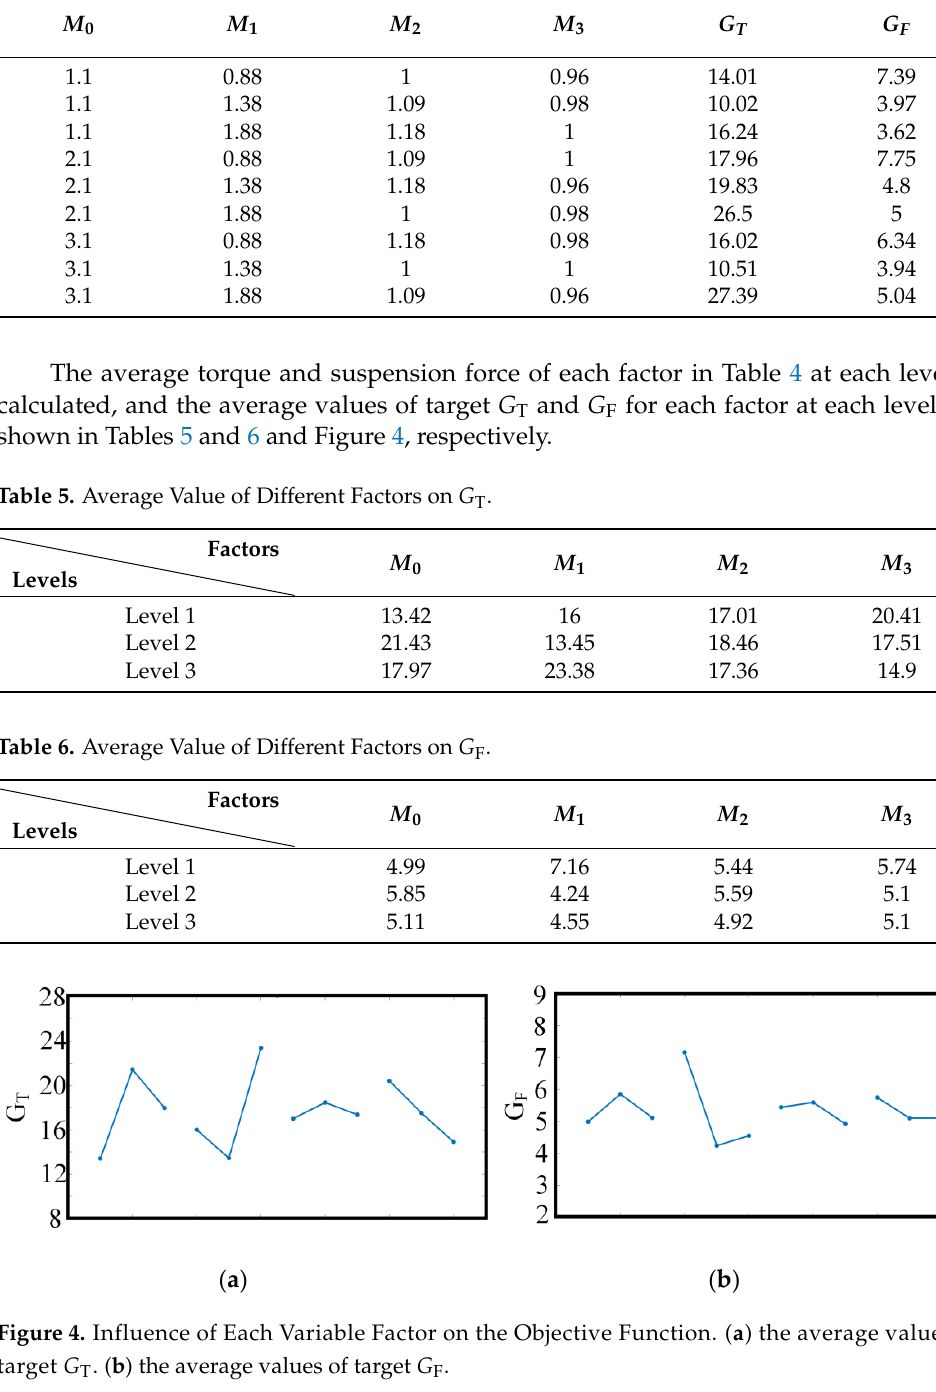
Table 4. Orthogonal Table and Results.